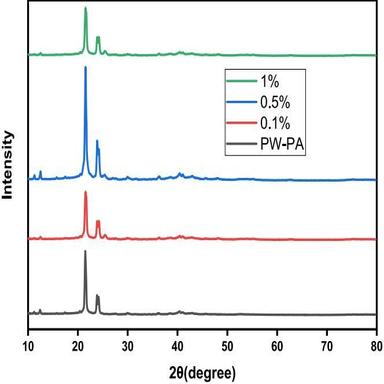
XRD pattern of the samples.